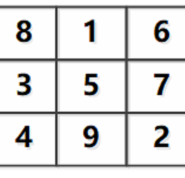
Figure 8. 3 × 3 magic square formation code.